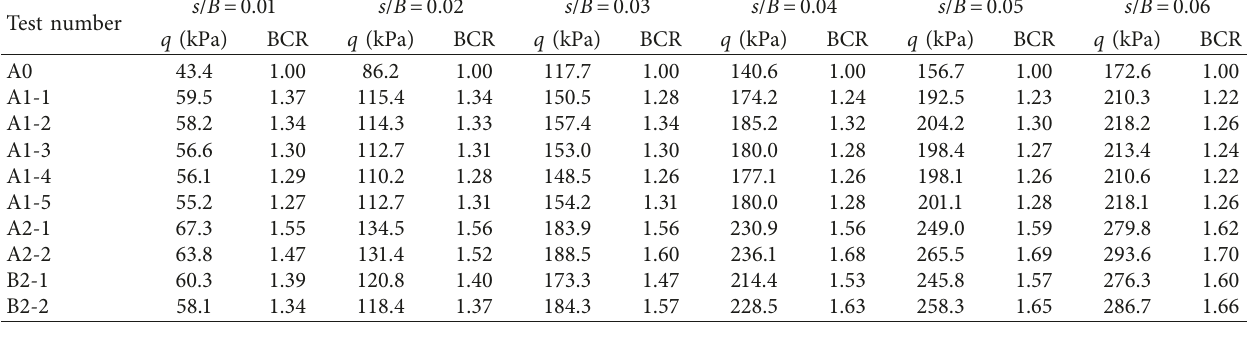
Table 5: The summary of test results.